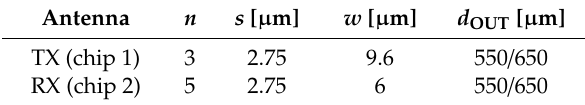
Figure 5. On-chip planar antennas mounted on a testing PCB for the S -parameter measurements. Table 1. Geometrical parameters of transmission (TX) and reception (RX) antennas.